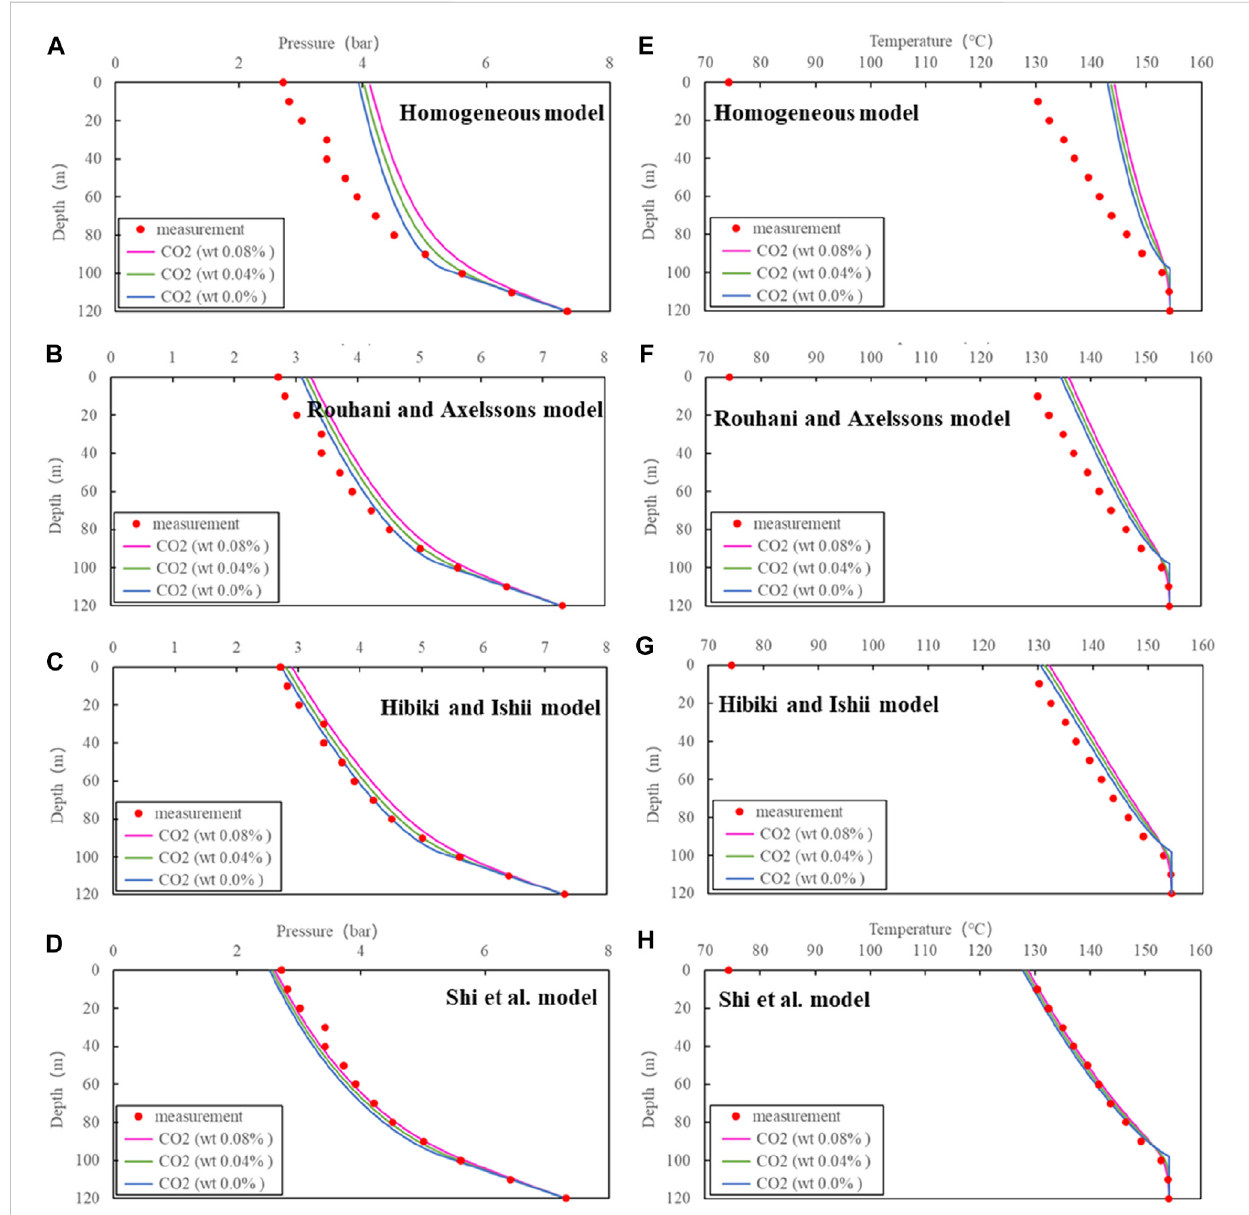
FIGURE 9 Comparison ofsimulations with different models and measurements for ZK304: (A) , (B) , (C) and (D) for pressure, (E) , (F) , (G) and (H) for temperature.